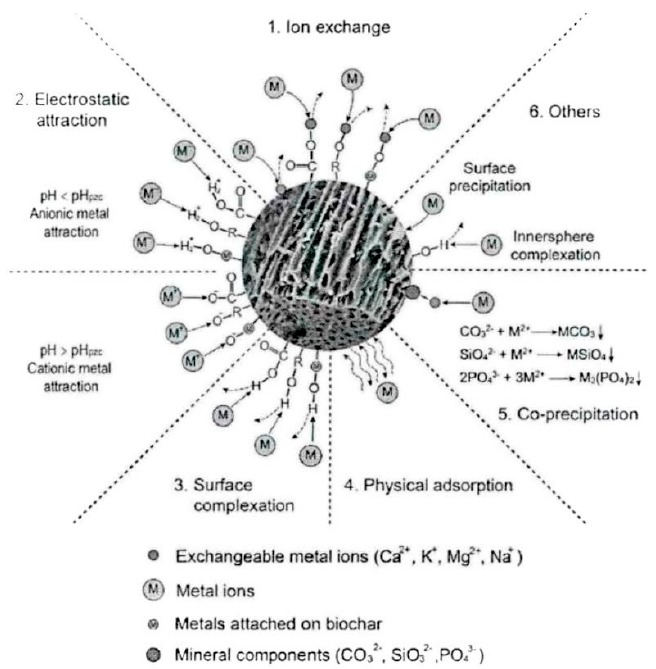
Figure 1. Adsorption mechanism of biochar.